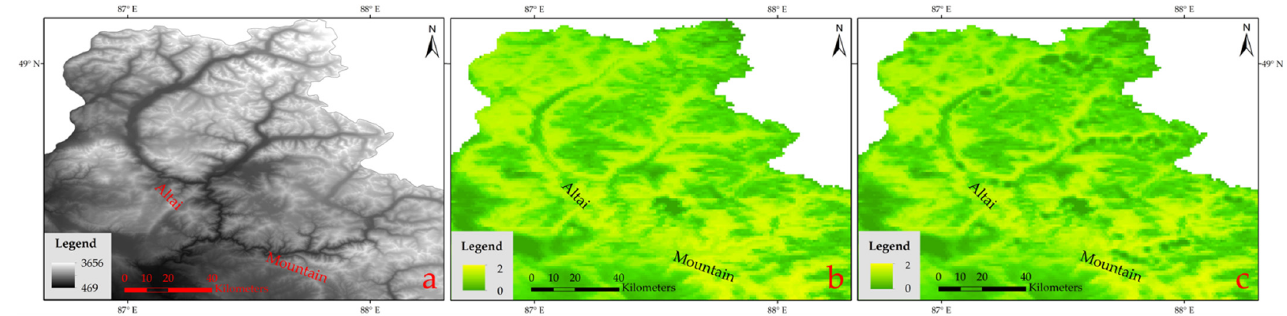
Figure 12. Change in the distribution of PV energy before ( b ) and after ( c ) adding the terrain shielding factor. ( a ) is the DEM in the north of Tianshan Mountain.